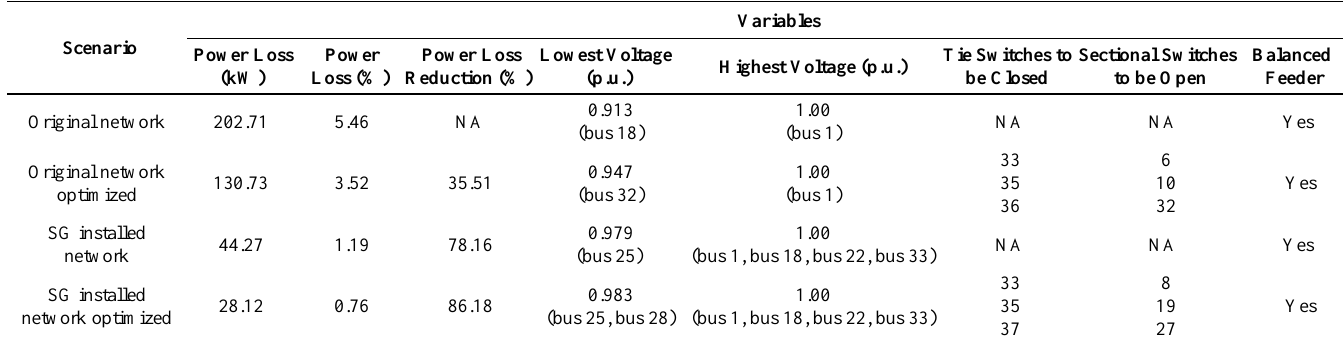
Table 2. Results of IEEE model distribution network